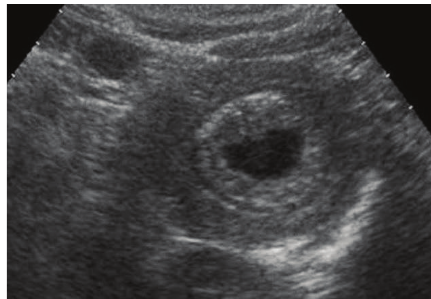
Figure 1: Abdominal ultrasound image depicts the typical image of intussusception with a simple cyst inside.